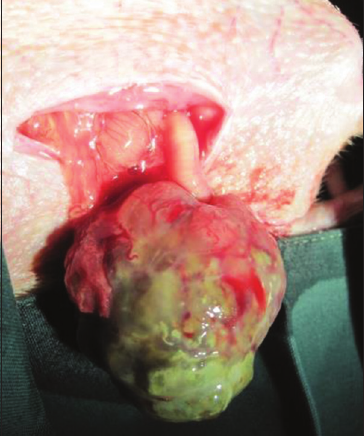
Figure-5: Surgical treatment of intra-abdominal abscess in